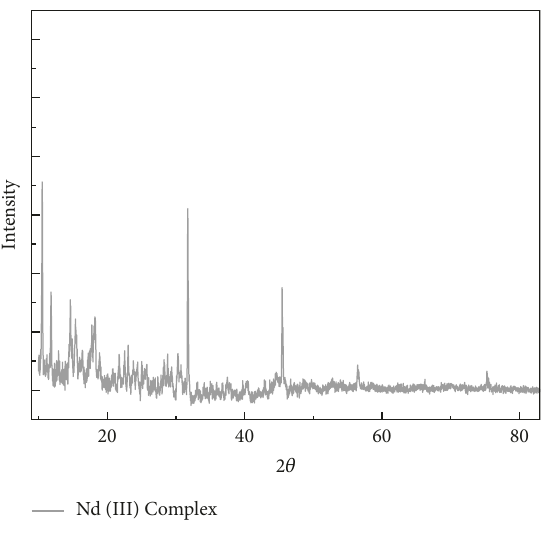
Figure 10: XRD pattern of Nd(III) compound.